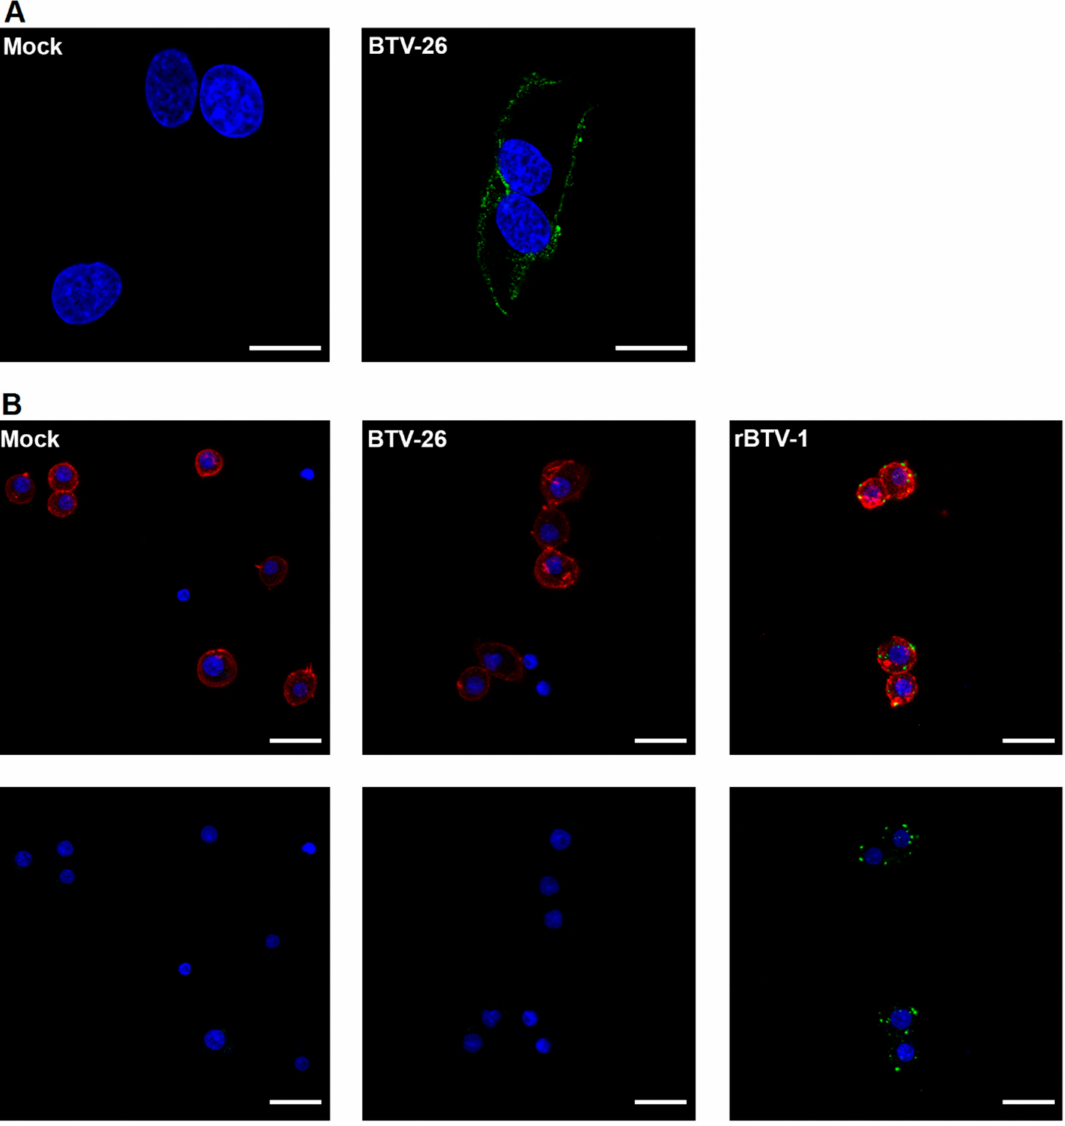
Figure 3. Binding ability of BTV-26 in mammalian and Culicoides midge cells. BSR ( A ) or KC ( B ) cells were either mock infected or infected with purified rBTV-1 ( B only) or BTV-26 ( A , B ) at a MOI of 100 ( A ) or 50 ( B ) in ice-cold conditions to prevent virus internalization. After 60 min, cells were washed three times with ice-cold serum-free medium, fixed with 4% PFA and labelled for DNA (DAPI-blue), Actin (Phalloidin-633, red) and BTV-1 (Orab279-Alexa Fluor 488, green) or BTV-26 (GT0128-Alexa Fluor 488, green). Cells were visualized by confocal laser scanning microscopy. In ( A ), the scale bar represents 20 µ m for all panels, while in ( B ), the scale bar represents 5 µ m, and it is a representative image of 3